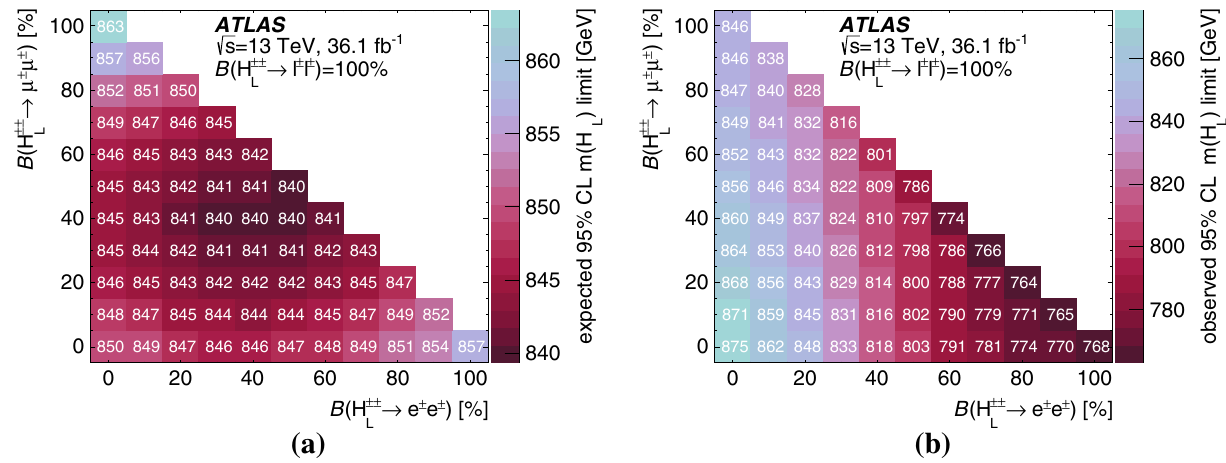
Fig. 11 The a expected and b observed lower limits on the H ±±